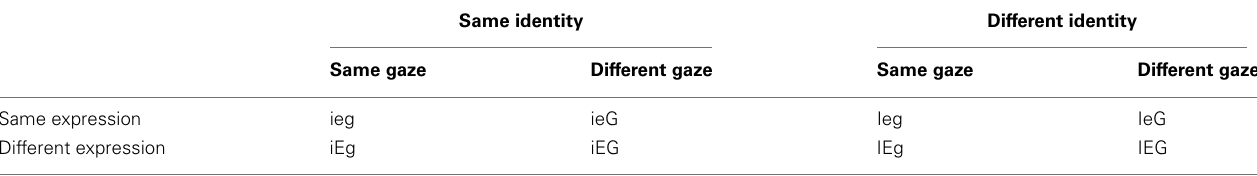
Table 1 | Factorialdesign for the same-different task.